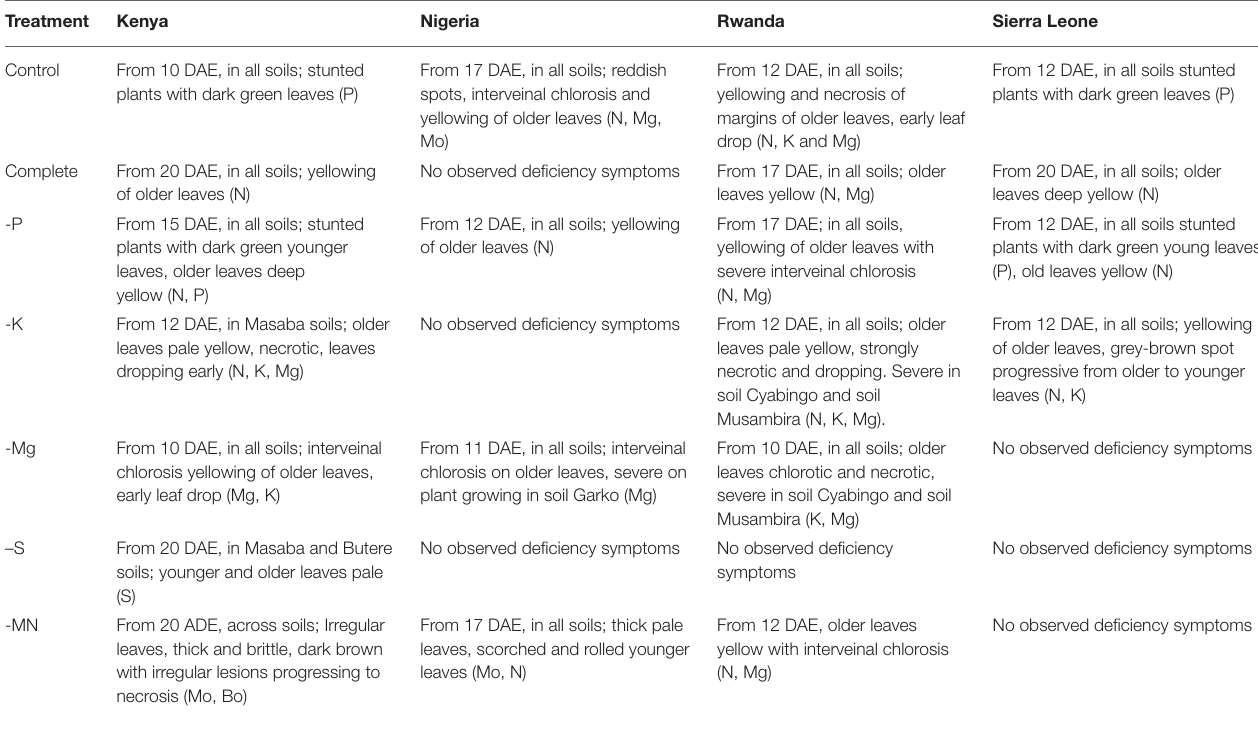
TABLE 5 | Symptoms of deficiency of nutrients (in bracket) and period when first observed on plants growing on a particular experimental soils for different treatments. Treatment Kenya Nigeria Rwanda